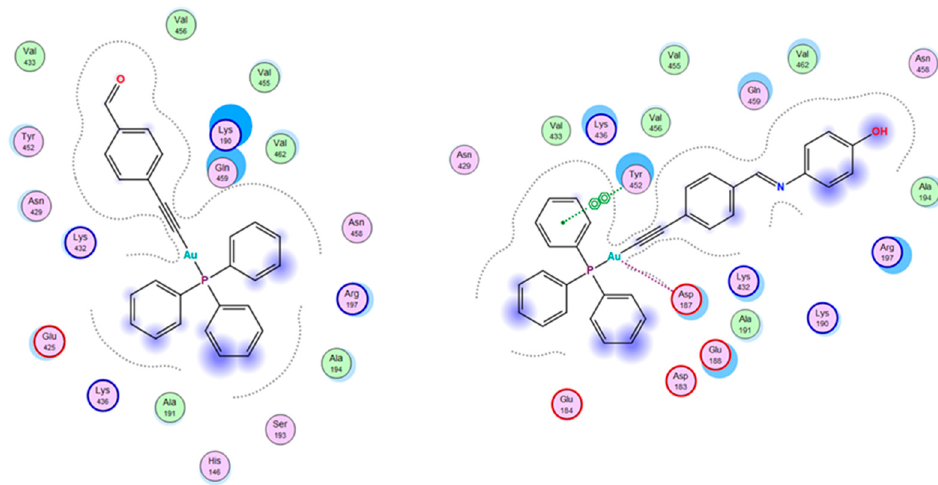
Figure 8. Comparison between the interactions of complexes 1 and 4 in the binding sites of HSA as predicted by MOE.